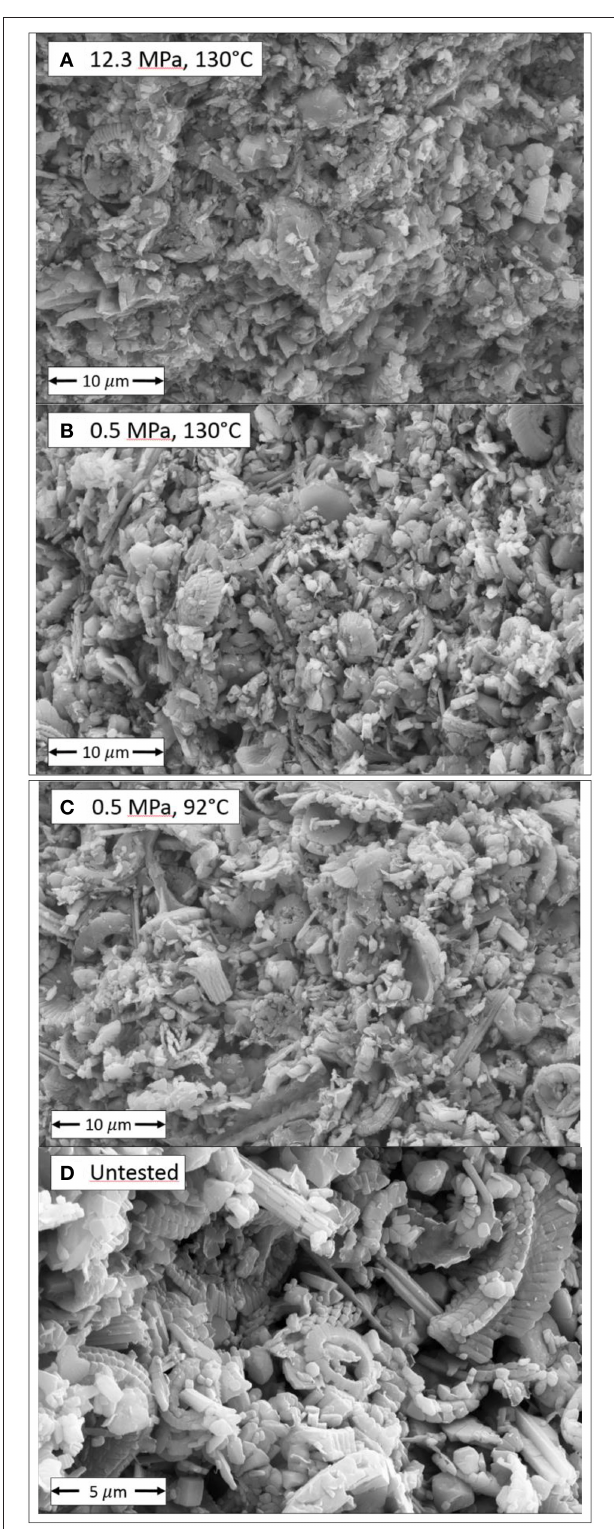
FIGURE 11 | High resolution SEM images of the microstructure of tested cores at varying effective stress and test temperature. Scale